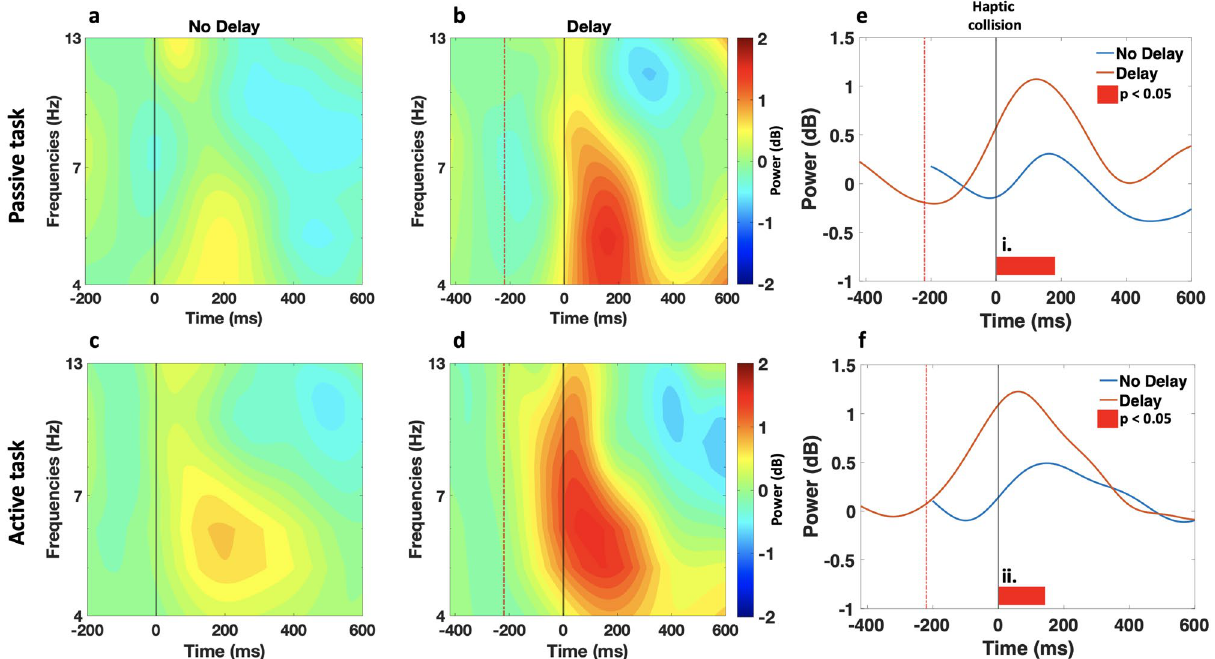
Figure 6. Midfrontal ROI time-frequency data ( a – d ) ERSP dynamics of the EEG data in the midfrontal ROI averaged over trials and subjects per condition and task. Time 0 ms corresponds to the haptic collision event denoted with a grey (solid) line, while the red (dashed) line denotes the event of the visual collision in the delayed condition. ( a , c ) Theta band activation centered around 200 ms is observed in the synchronous condition. ( b , d ) As a result of the haptic delay, theta activation power is increased. Under the delayed condition, theta activation pattern during the passive task differs from that during the active task. Under the delayed condition and during the passive task, theta activation sharply increases around the introduction time of the delayed haptic feedback. In contrast, during the active task, theta activation increases earlier, right after the visual collision and the missed haptic feedback. ( e , f ) Time-course of theta power (4–9 Hz) under the no delay (blue) and delay (orange) conditions time-locked to the haptic collision. Both waveforms are plotted starting with their corresponding baseline (200 ms before the visual collision). Significant time window is (i. 0–180 ms; p range < 0.05 , randomization test, FDR corrected) for the passive task and (ii. 0–140 ms; p < 0.05 , randomization test, FDR corrected) for the active